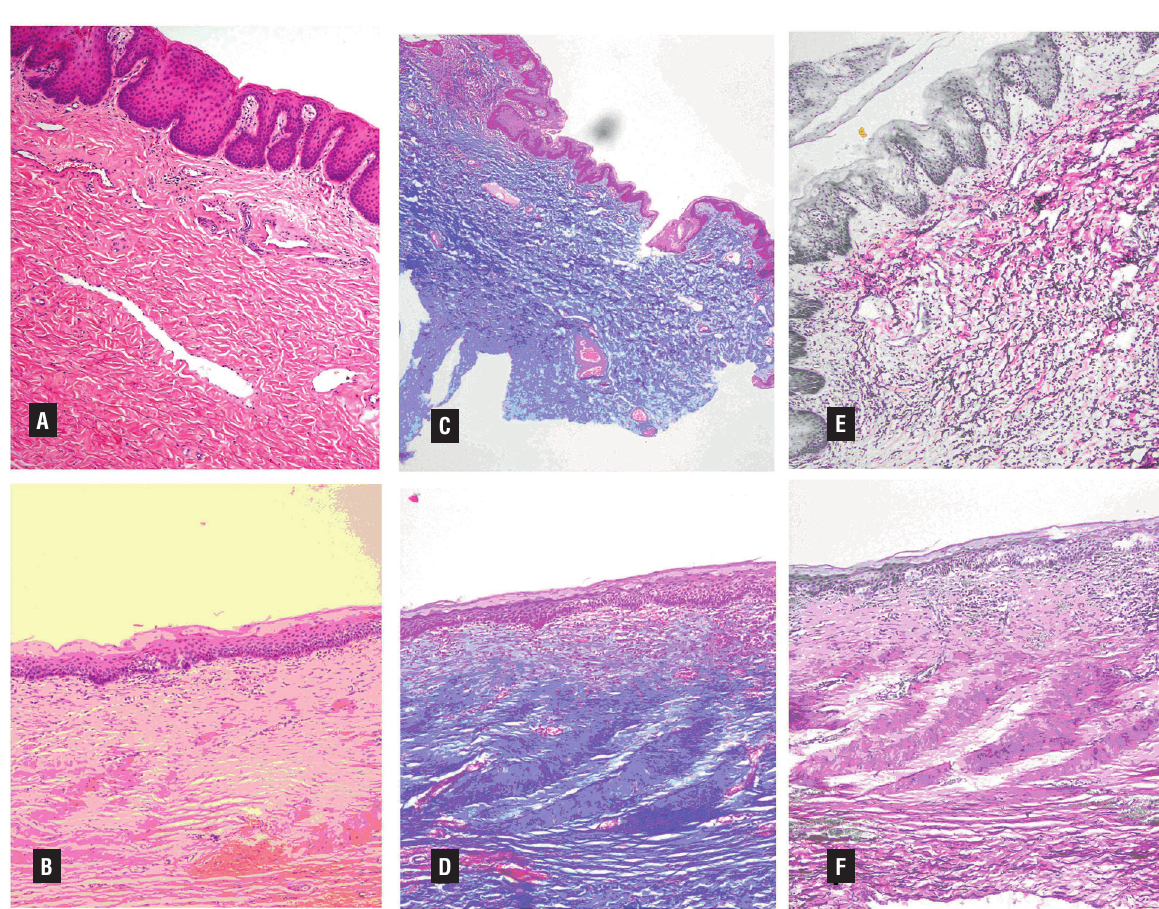
Figure 2 - Histopathological examination of the normal tunica albuginea (A, C, and E) and repaired area (B, D, and F). In slide A (H&E), the section is from the normal area and shows the squamous epithelium with papillary structures. In slide B(H&E), the section is from the grafted area after 12 weeks and illustrates complete squamous re-epithelialization. However, the papillary structure of the epithelium became flattened to some extent. Also, scattered chronic inflammation was seen in this slide. In slide C, Masson’s trichrom staining of the normal area was seen. In slide D, similar staining of the repaired area exhibits dense collagen fibers deposition 12 weeks after grafting. Slides E and F demonstrate Verhoeff-van Gieson elastin staining of the normal and repaired areas, respectively. The comparison between these two slides shows decreased elastin fibers after grafting (Magnification: